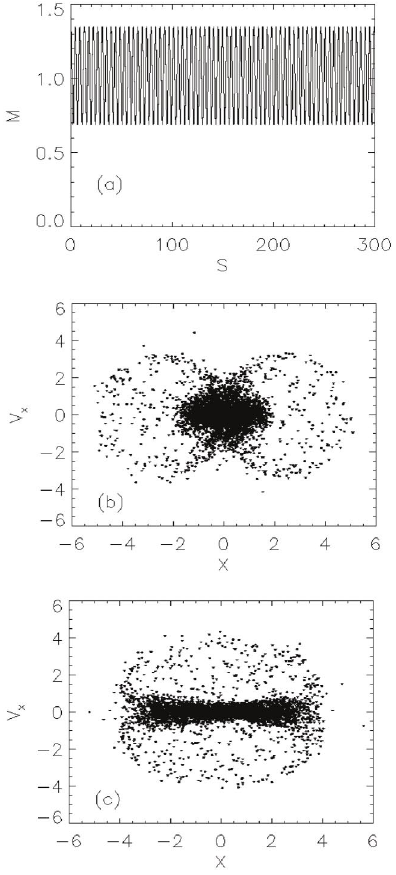
FIG. 2. Nonlinear oscillations. (a) Oscillation of the rms width of the core with (cid:4) (cid:1) 1 : 35 , (b) particle distribution at last minimum rms width when S (cid:10) 300 , (c) distribution at last maximum rms width when S (cid:10) 300